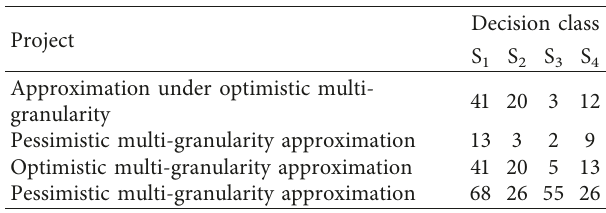
Table 4: Zo multiple granularity correlation approximations.